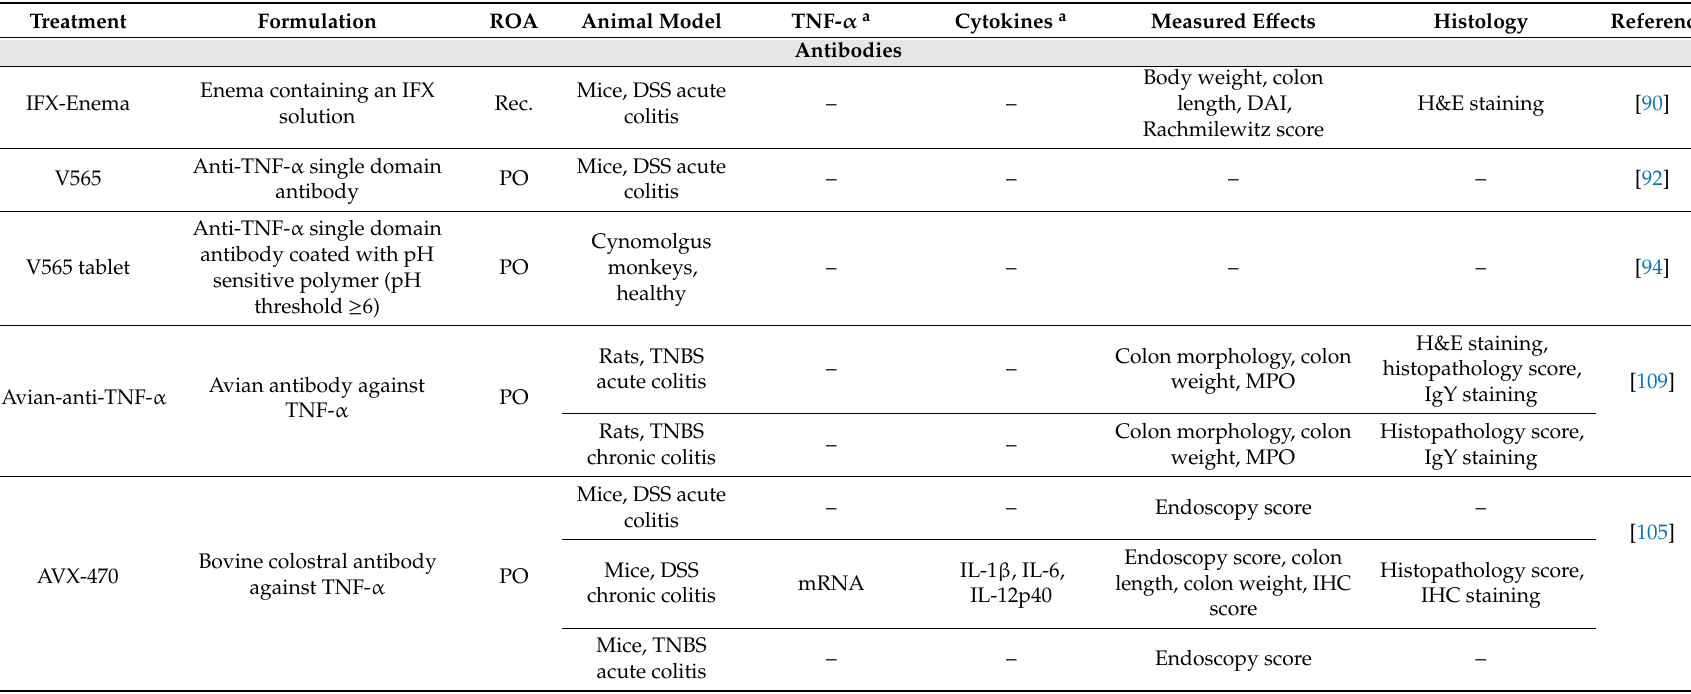
Table 1. Summary of the animal studies investigating the local e ff ects of anti-TNF- α therapy. Abbreviations: AAT—alpha 1-antitrypsin; ASO—antisense oligeonucleotide; DAI—disease activity index; DSS—dextran sodium sulfate; Fab’—antigen-binding fragment; Fc—fragment crystallizable region; GM-CSF—granulocyte-macrophage colony-stimulating factor; H&E—hematoxylin and eosin; IC—intracolonic administration; ICH—immunohistochemistry; IFN- γ —interferon-gamma; IFX—infliximab; Ig—immunoglobulin; I κ B- α —nuclear factor of Kappa light polypeptide gene enhancer in b-cells